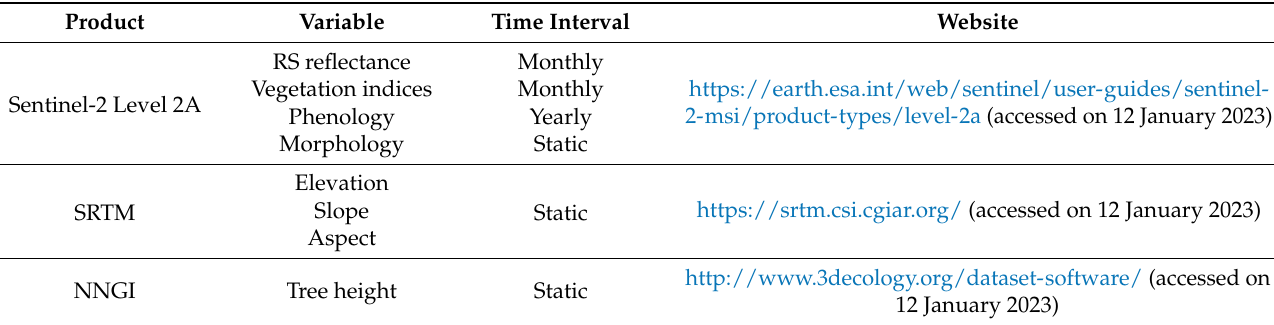
Table 1. Remote sensing product used in this